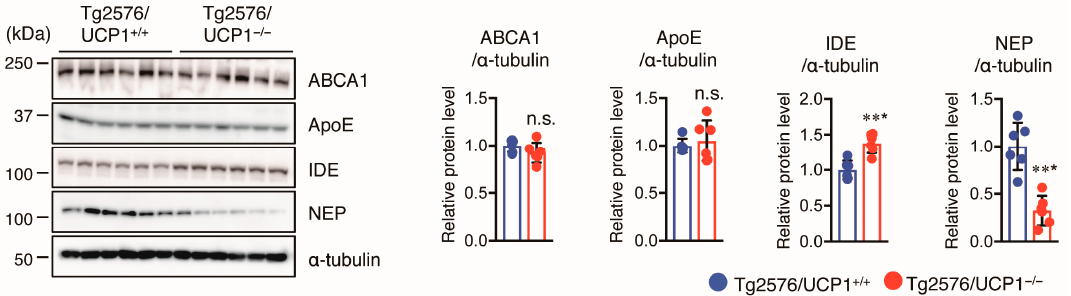
levels were significantly increased in the cortex of Tg2576/UCP1 − / − mice compared with Tg2576 mice housed at 30 ◦ C, which indicates that high body temperature accelerates A β 42